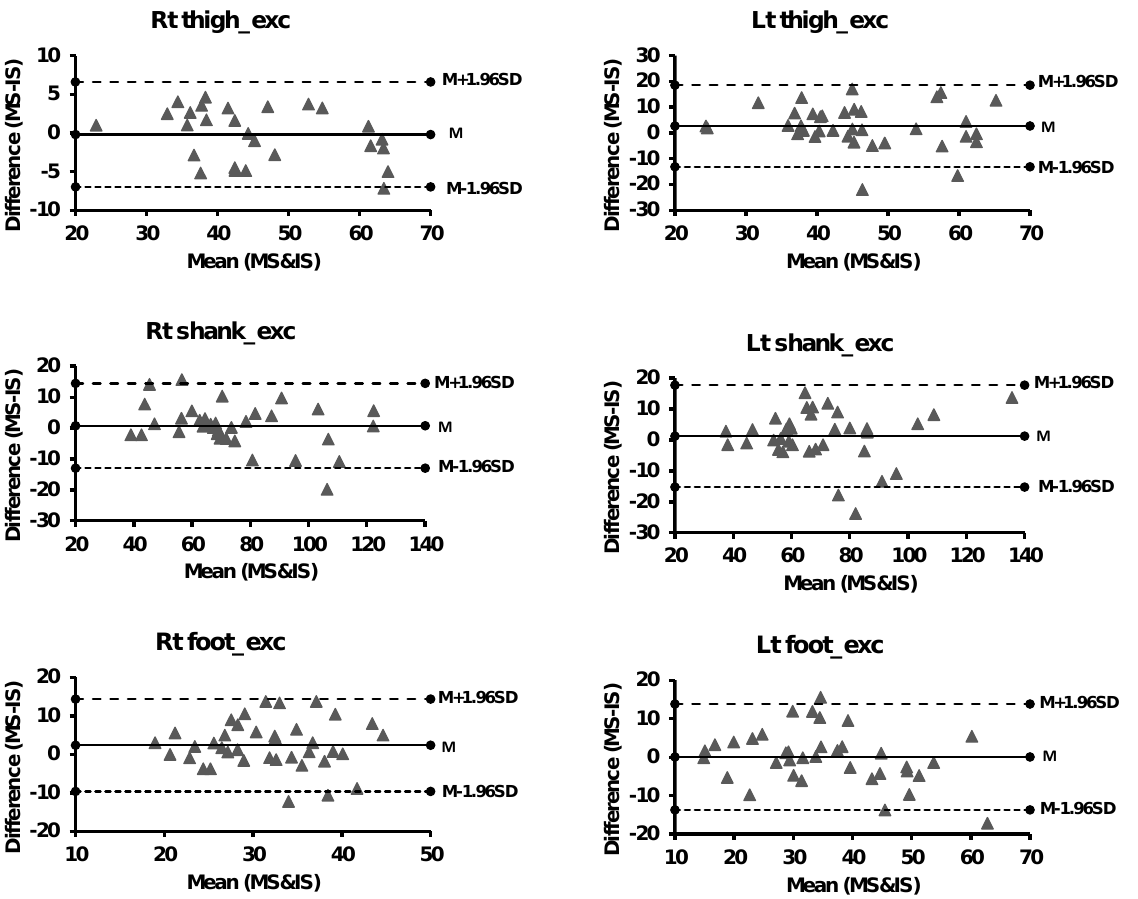
Figure 2. Bland-Altman plots of segment mobility measures (Dance test) for motion (MS) and inertial sensor (IS) systems. The solid line represents the mean (M), while the two dash lines above and below M represent the upper (M + 1.96 SD) and lower (M − 1.96 SD) limits of agreements (1.96 standard deviations), respectively. Abbreviation: Lt = Left, Rt = Right, exc = excursion.